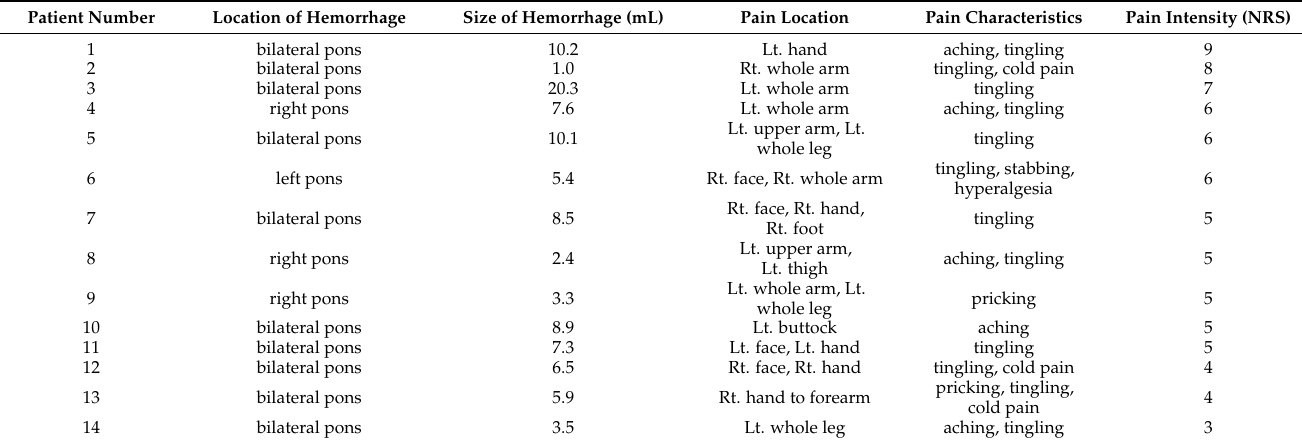
Table 2. Location and size of hemorrhage and corresponding pain location and characteristics for each patient with central post-stroke pain.